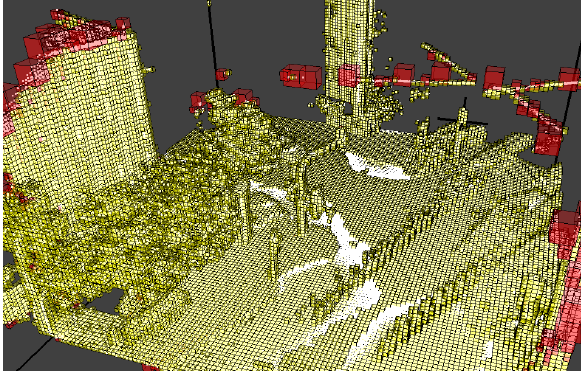
Figure 3. Iterative approximation of a street without the final state estimation (red= occupied , yellow= split ; free space is not